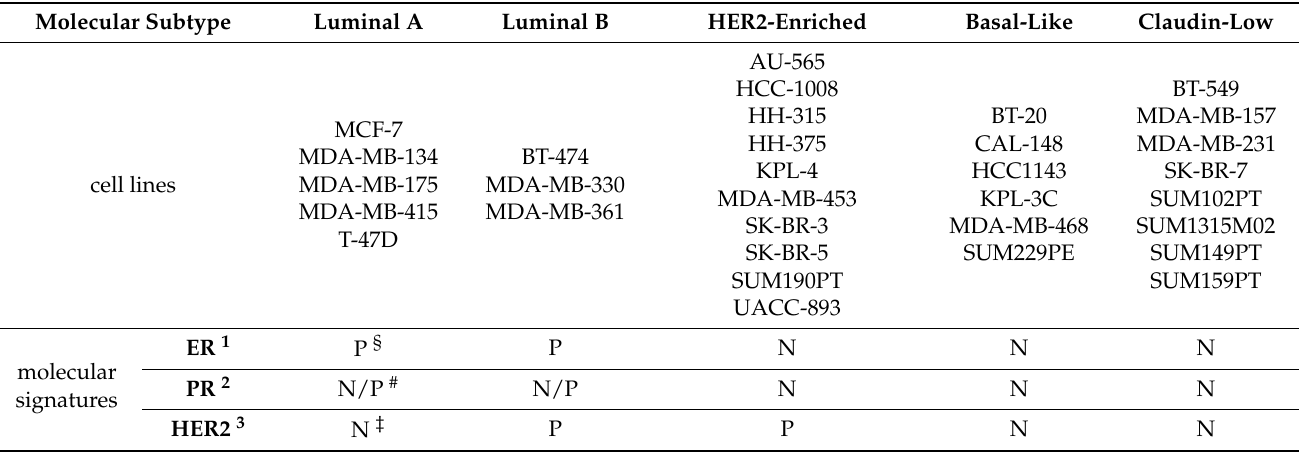
Table 1. Breast cancer subtypes, molecular information, and permanent cell lines established from them